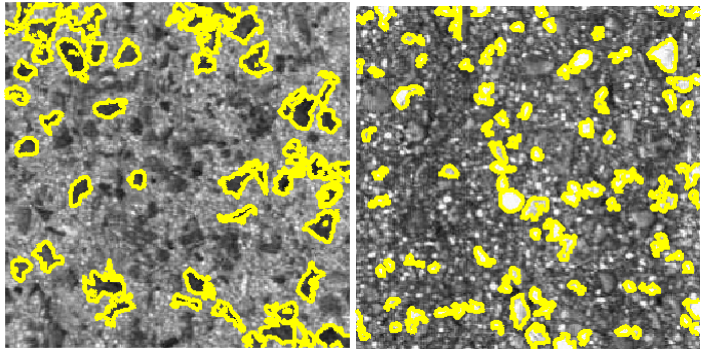
Figure 9. MSER detection results. Left : black blobs. Right : white